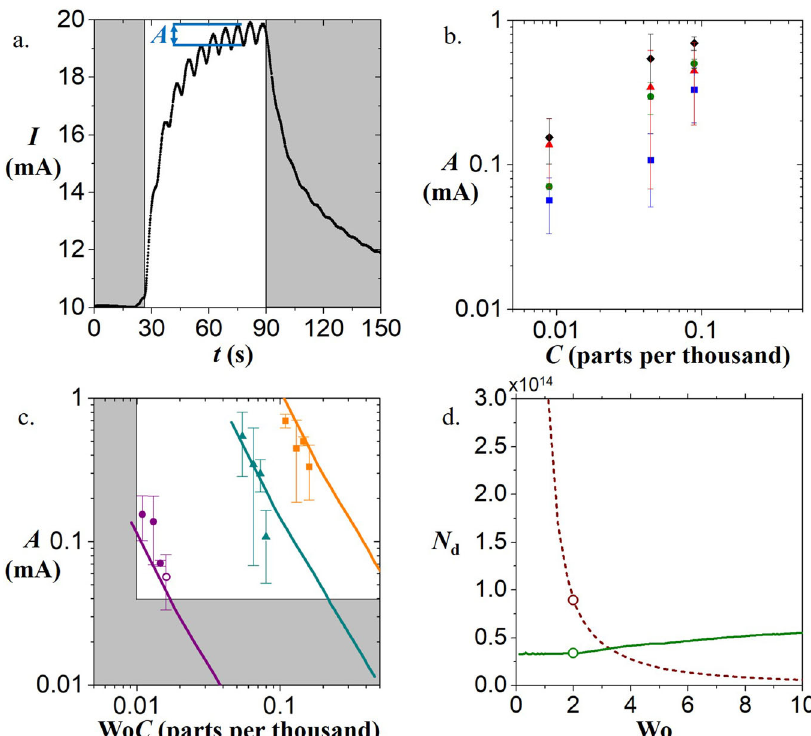
Fig. 6 Sensor response due to snif fi ng air fl ows. a Time course t of the current I across sensor due to introduction of 89 parts per thousand concentration of ethanol at t = 30 sec. In the shaded regions, the ethanol sample bottle is absent from the space; in the remaining regions, the ethanol is present. b Relationship between estimated concentration C of ethanol in headspace and current amplitude A . Black diamonds, red triangles, green circles, and blue squares indicate response for frequencies of 0.14, 0.2, 0.25, and 0.3 Hz with associated Womersley numbers of 1.25, 1.5, 1.65, and 1.8 respectively. Error bars represent one standard deviation (s.d.). c Relationship between amplitude A and product of Womersley number Wo and concentration C . Data collected at concentrations of 8.9 parts per thousand, 44 parts per thousand, and 89 parts per thousand represented by the purple circles, cyan triangles, and orange squares respectively. Mathematical models for concentrations of 8.9 parts per thousand, 44 parts per thousand, and 89 parts per thousand represented by the purple, cyan, and orange solid lines respectively. Shaded region shows where no additional information can be obtained by snif fi ng. At a Wo C of less than 0.01, the response returns to baseline each sniff. Below 0.03 mA, no measurable response can be obtained due to the signal dropping underneath the noise threshold of the sensor. Open purple circle represents the optimal collection rates for the 8.9 parts per thousand concentration tests with the chosen sensors. Error bars represent one standard deviation (s.d.). d The relationship between number of available molecules for collection N d and Womersley number. Dashed red line indicates number of molecules available per cycle. Solid green line indicates the number of molecules available per second. Open red and green circles represents collection rates for 8.9 parts per thousand